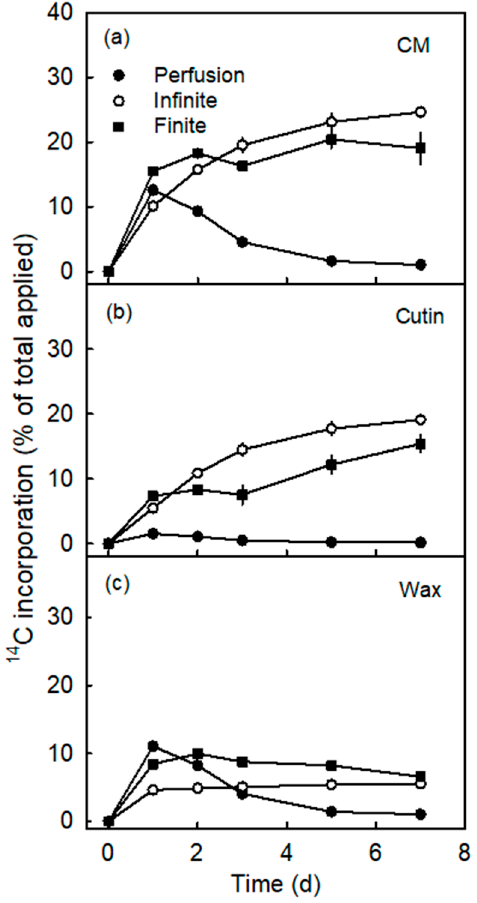
Figure 3. Time course of 14 C incorporation (% of total applied) in cuticular membrane (CM) ( a ), cutin ( b ) and wax ( c ). 14 C labelled oleic acid was applied to the excised exocarp segments (ES) of young ‘Idared’ apples, sampled at 62 days after full bloom (DAFB), using three different application methods. The values are means ± SEs of 15 replications.